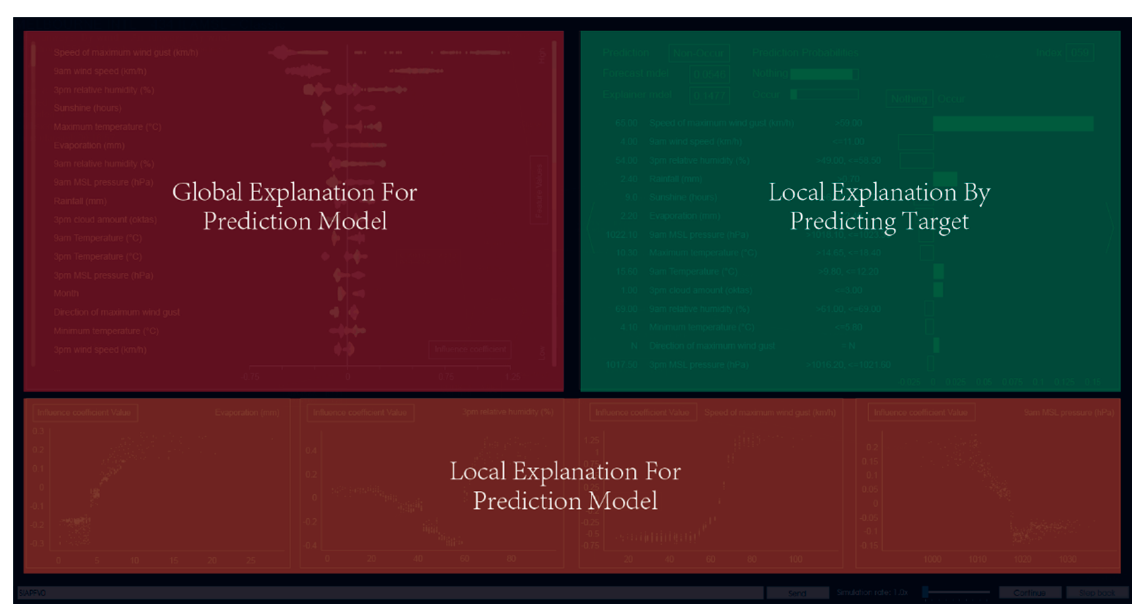
Figure 16. The layout of the detailed explanation interface concept.